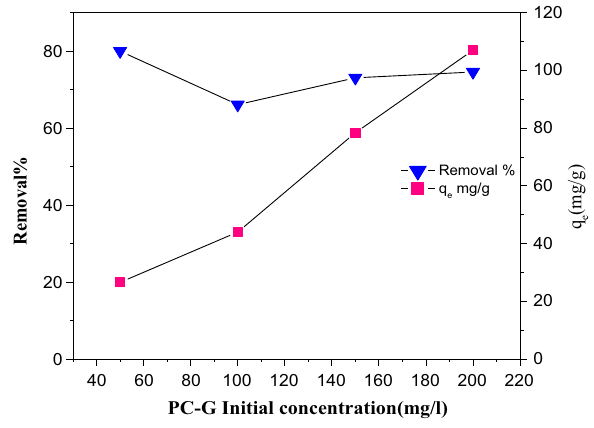
Fig. 5 Effect of PC-G initial concentration on removal efficiency of PC-G on MgO nanoparticles. (Adsorbent dosage = 1.5 g/L, pH = 3, and contact time = 60 min)